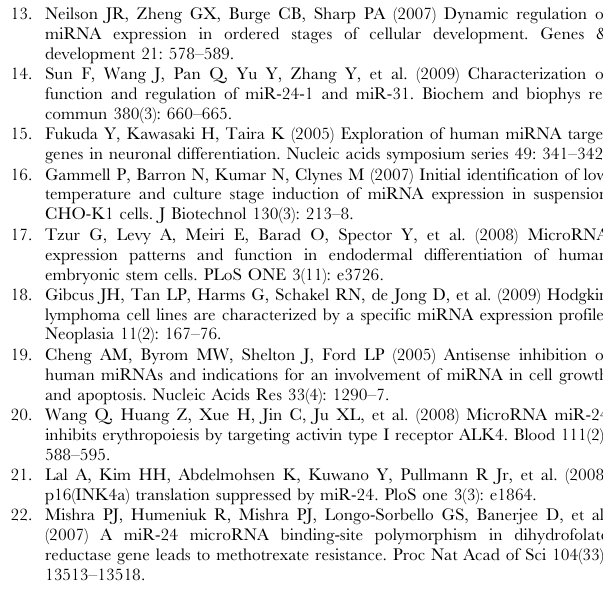
Table S1 Anchorage independent growth ability of